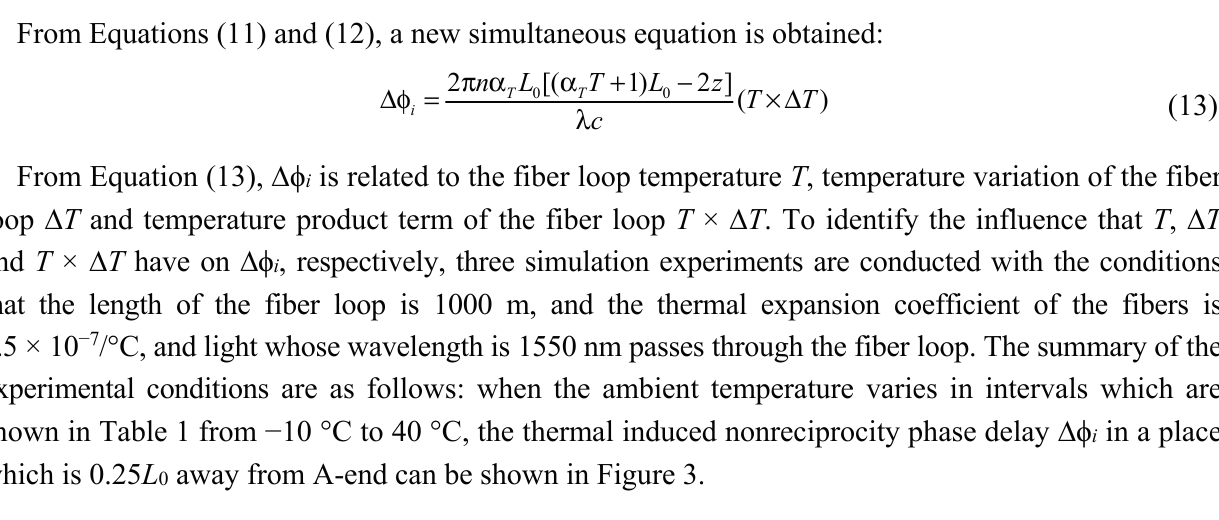
Table 1. Simulation experimental conditions.